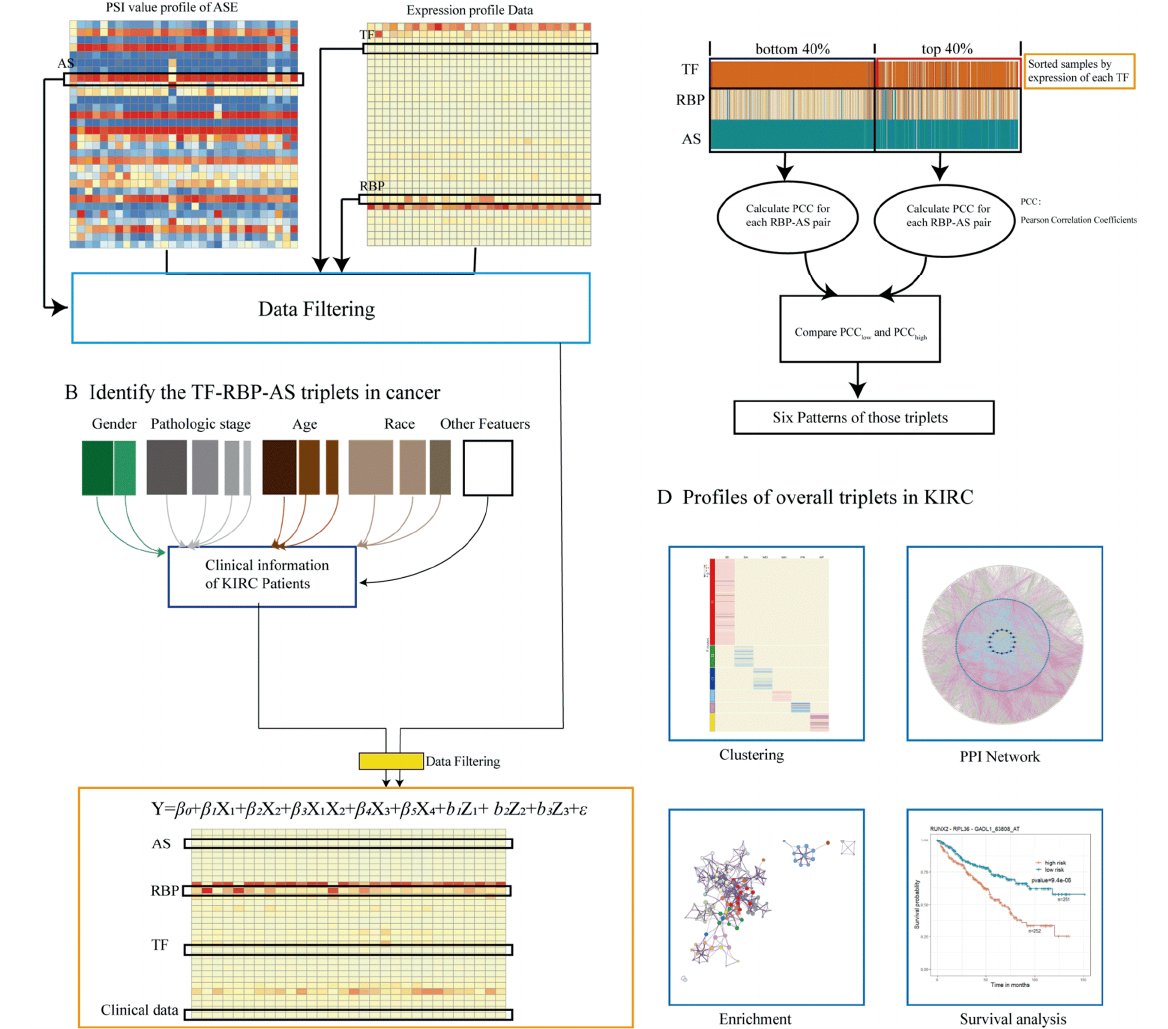
Figure 6. Research methodology. ( A ) Key ASEs and differentially expressed RBPs and TFs were identified, expression data of RBP and TF and PSI value of ASE were integrated, relevant clinical information of the patient from the data of TCGA-KIRC was extracted, and all data were integrated. ( B ) The linear mixed-effects model was used to predict triplets. Only triplets with significant β 1 , β 2 , and β 3 p values were considered and selected for the following analysis. Each triplet contains three objects: the expressions of TF and RBP and the PSI value of ASE. ( C ) For each triplet, we grouped samples into “low” and “high” groups on the basis of the expression level of TF (bottom/top 40% samples) in the specific triplet, and we compared Pearson’s correlation coefficient values of RBP expression and PSI value of ASE in two groups, identifying TF function categories. ( D ) In order to explore the prognostic value of these triplets, clustering analysis was performed, and a PPI network was constructed; enrichment and survival analyses were carried out.